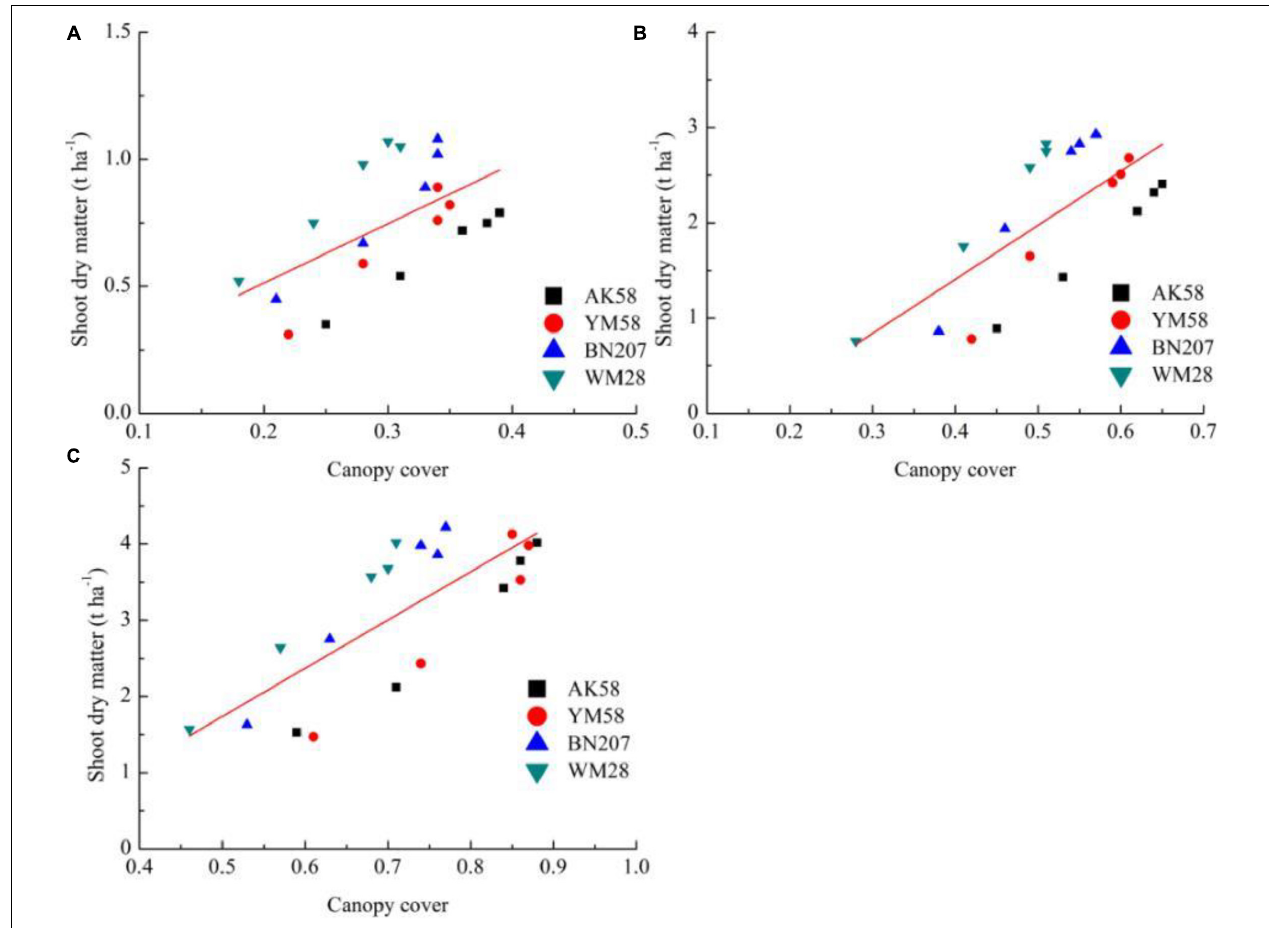
FIGURE 5 | The relationship between canopy cover and shoot dry matter across different growth stages of winter wheat [ (A) Feekes 3; (B) Feekes 5; (C) Feekes